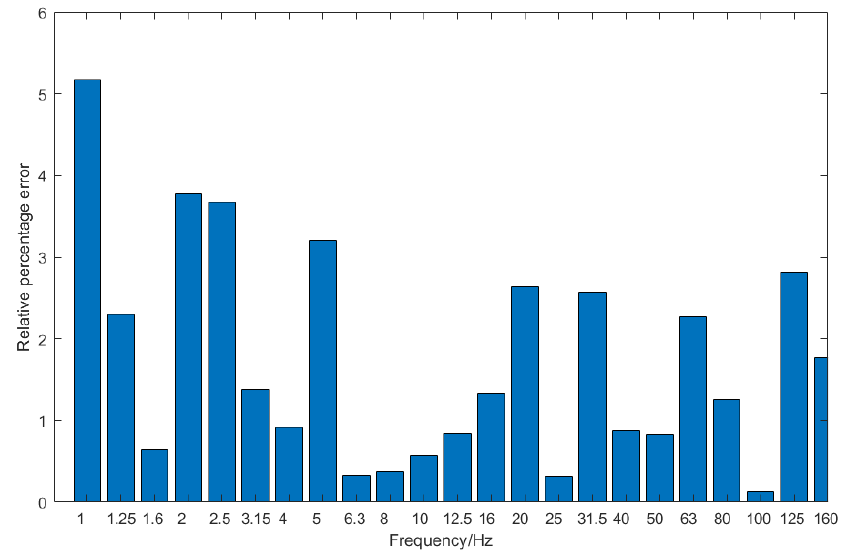
Figure 24. Comparison of acceleration of the one-third octave spectrum from Channel 7 using processed data.